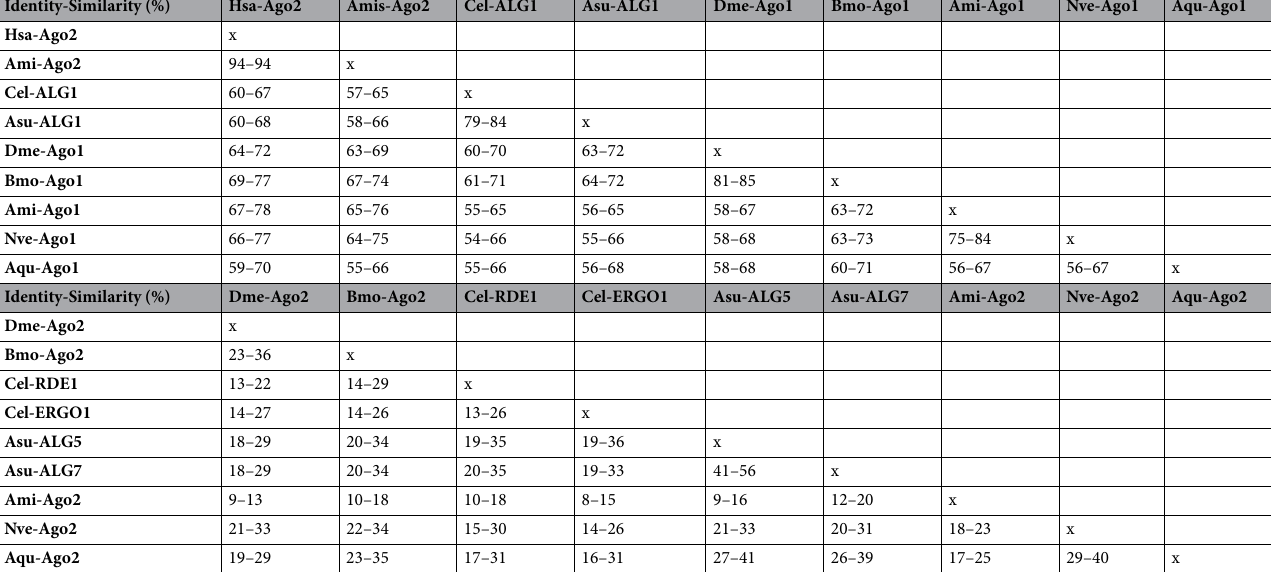
Table 1. Sequence identity and similarity between different metazoan miRNA-class AGOs (upper table) and siRNA-class AGOs (lower table). The miRNA-class AGO sequences used are of Homo sapiens (chordate, Hsa-Ago2), Alligator mississippiensis (chordate, Ami-Ago2), Caenorhabditis elegans (nematode, Cel-ALG1), Ascaris suum (nematode, Asu-ALG1), Drosophila melanogaster (insect, Dme-Ago1), Bombyx mori (insect, Bmo-Ago1), Acropora millepora (cnidarian, Ami-Ago1), Nemastella vectensis (cnidarian, Nve-Ago1), and Amphimedon queenslandica (sponge, Aqu-Ago1). The siRNA-class AGOs used are of C. elegans (nematode, Ce-RDE1 and Ce-ERGO1), A. suum (nematode, Asu-ALG5 and Asu-ALG7), D. melanogaster (insect, Dme- Ago2), B. mori (insect, Bmo-Ago2), A. millepora (cnidarian, Ami-Ago2), N. vectensis (cnidaria, Nve-Ago2) and identity, while the second value stands for the percentage of sequence